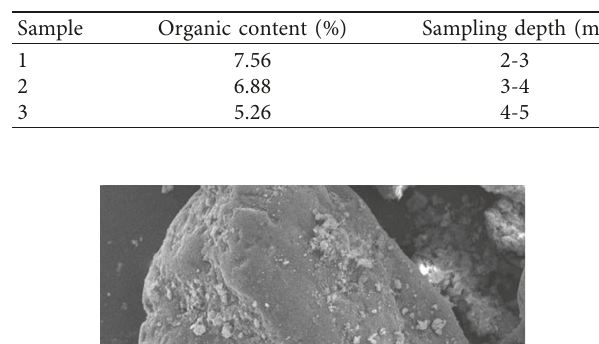
Figure 1: Map of key coastal bays in Hainan Province (Map data © 2018 Google). Table 1: Organic content of sand specimens from different sam- pling depths.